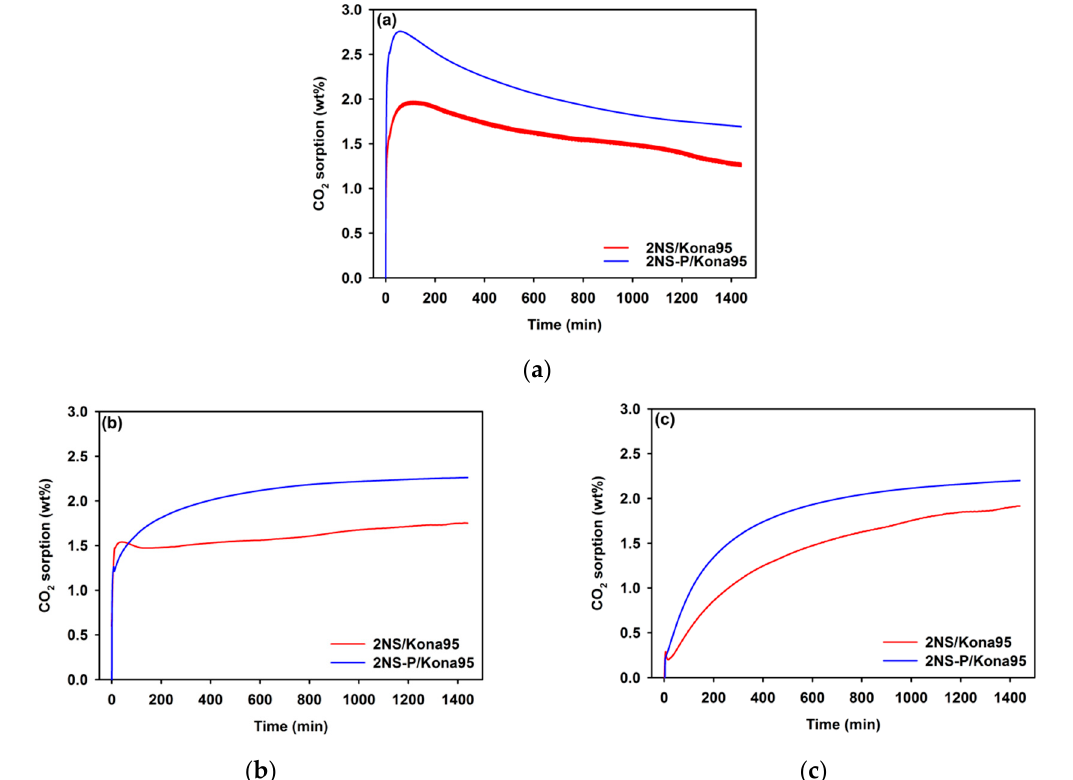
Figure 2. Change in mass of the adsorbents upon exposure to 100% CO 2 at ( a ) 110, ( b ) 130, and ( c ) 150 °C.